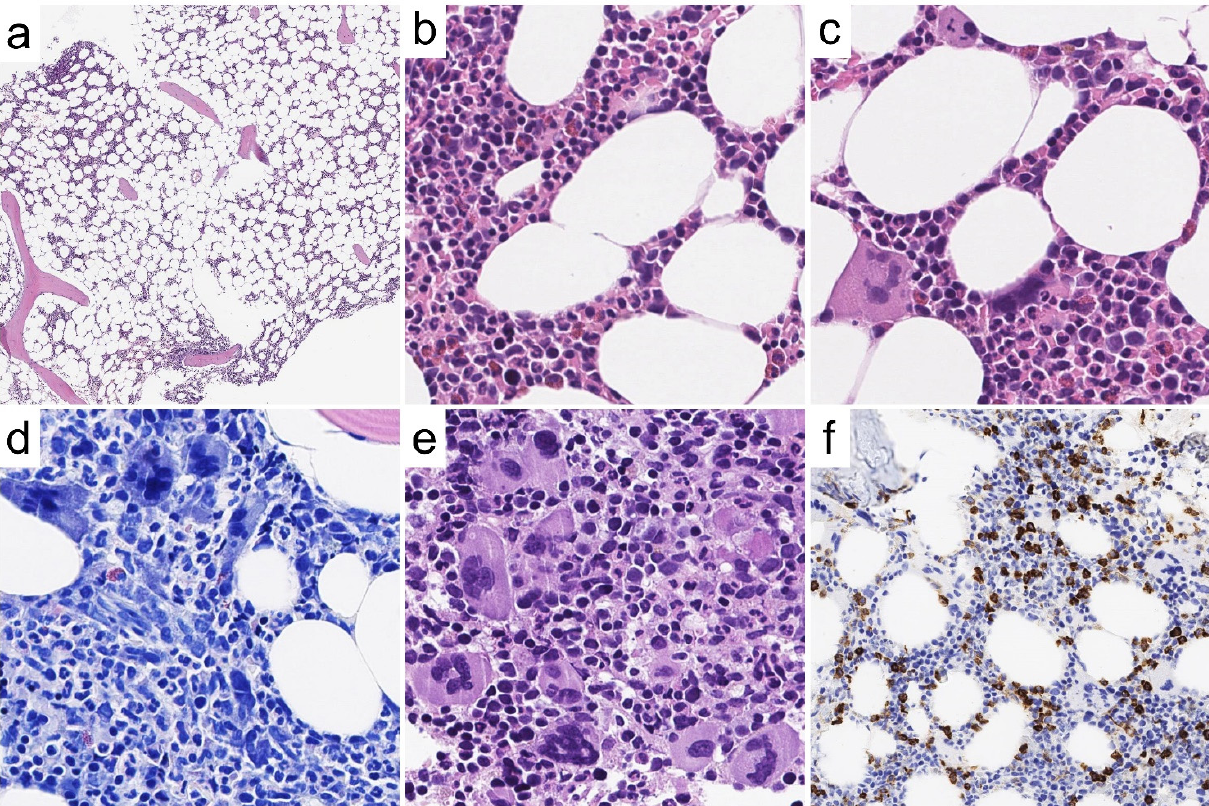
Figure 4 . Representative histological features of case #5 and #6. BM biopsy from case #5 ( a – c ) shows a hypocellular marrow ( a ; H/E, 40×), featuring, at least focally, a mild decrease in myeloid-to-erythroid ratio without maturation defects ( b ; H/E, 400×), and scattered MPN-like, giant hyperlobulated megakaryocytes ( c ; H/E, 400×). BM biopsy from case #6 ( d – f ) depicts hypercellularity with increased myeloid-to-erythroid ratio, myeloid left shifting and clustering of megakaryocytes with hyperlobated forms and maturation defects ( d ; Giemsa, 400×; e ; H/E 400×); a well-represented CD14+ monocyte population is present ( f ; 200×).